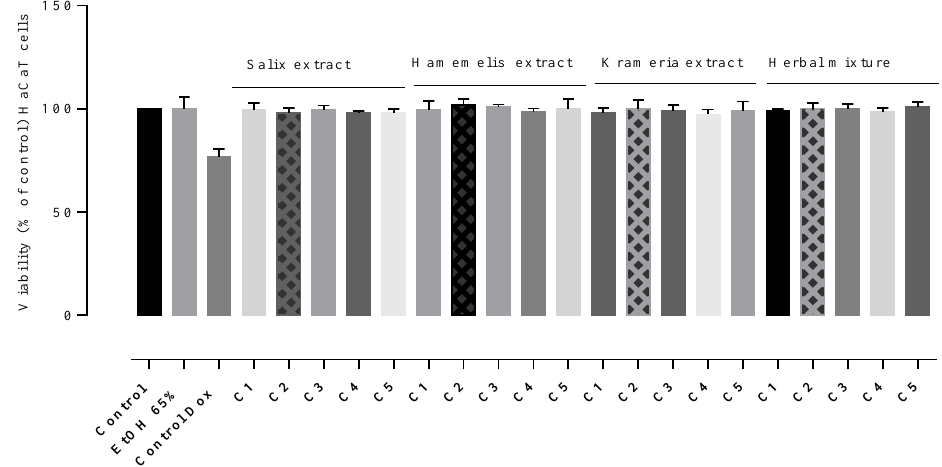
Figure 1. HaCaT cell line viability induced by the individual extracts and HM, evaluated at five concentrations (C1–C5) were established based on TPC values (mg GAE). The tested concentrations ranged between 0.0418 and 0.209 for S. alba extract, 0.0498 and 0.249 for H. virginiana extract, 0.0354 and 0.1761 for K. lappacea extract, and 0.0420 and 0.21 for HM. Negative control, untreated cells, Positive control, Doxorubicin (5 µM). Internal control, cells treated with 65% v / v ethanol solution (EtOH). Values represent the mean ± SD of three independent evaluations.